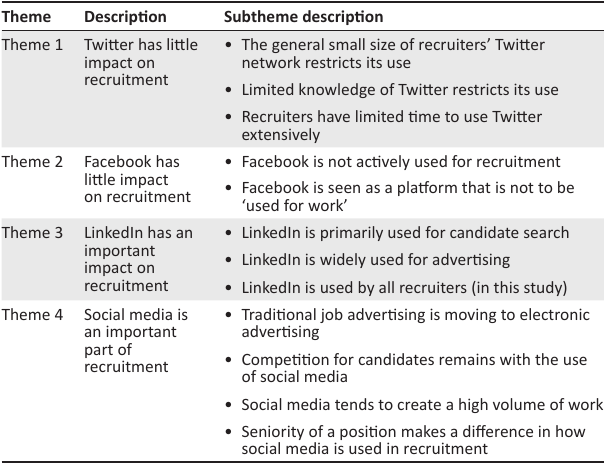
FIGURE 1: Percentage of recruiters using social media in their sourcing process. TABLE 1: Themes and subthemes identified from the